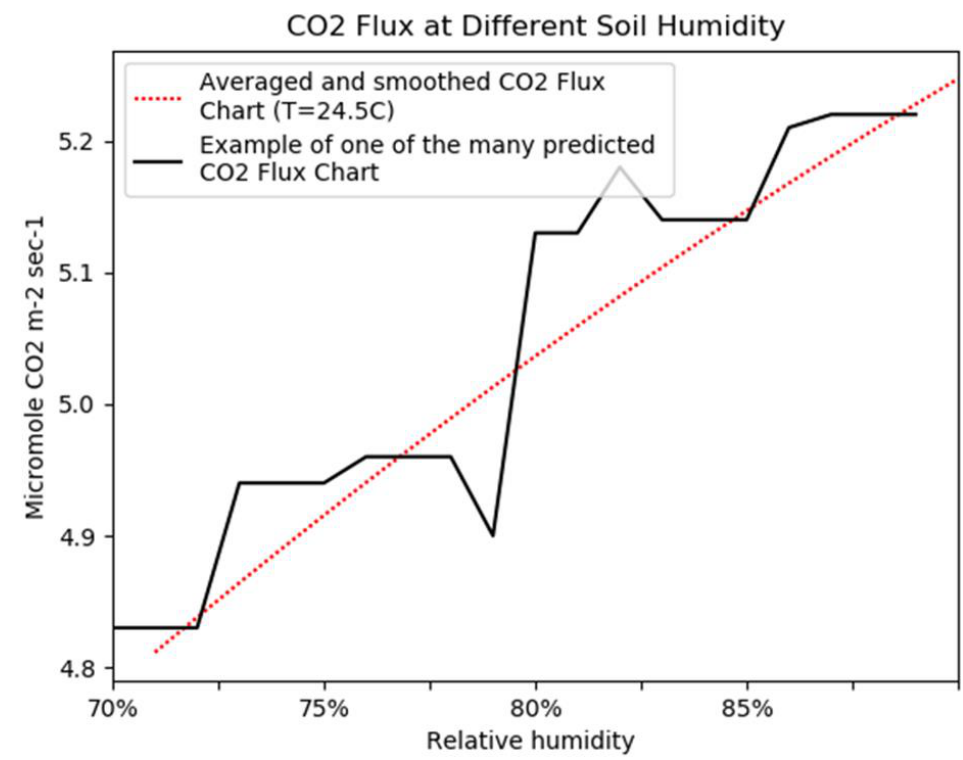
Figure 9. Results of experiment 8. Dependence of CO 2 flux rate on values of parametric pairs (T — soil temperature, rH — soil relative humidity).